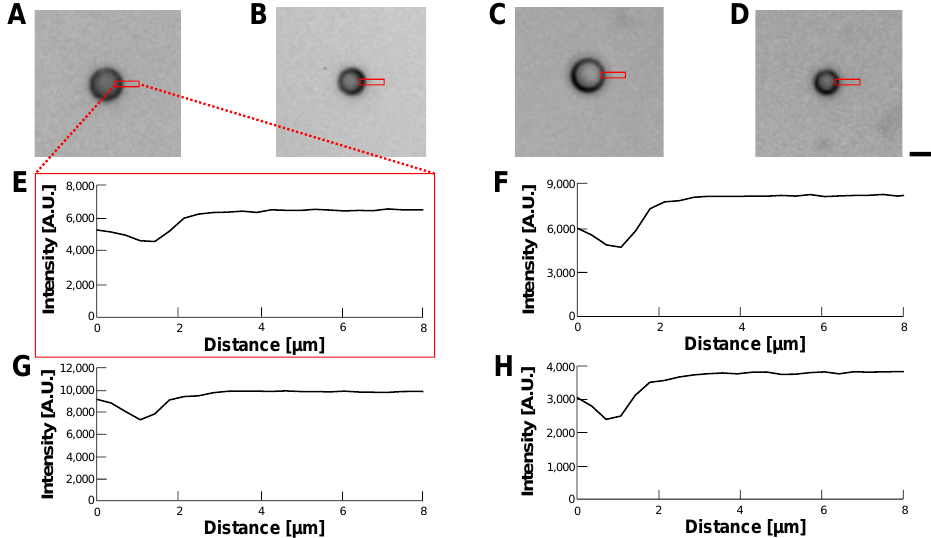
Figure 13. Comparision of permeability of empty alginate microcapsules in various buffer con- ditions by bright-field observation. ( A – D ): Bright-field images of empty alginate microcapsules. ( A ): 5% glucose solution ( B ): 10% glucose solution ( C ): 15% glucose solution ( D ): 1% alginate ester. ( E – H ): Intensity profiles of empty alginate microcapsule images ( A – D ), respectively. Bar,